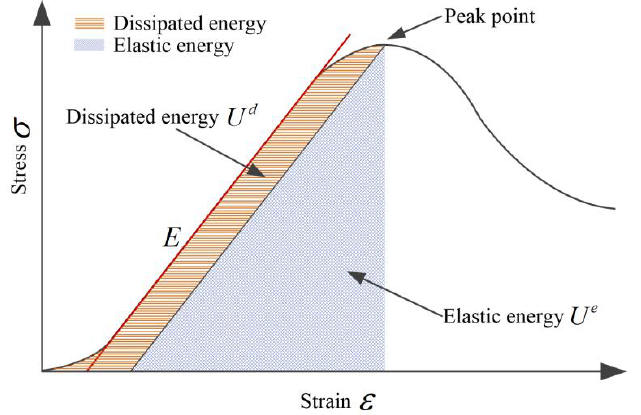
Figure 7. Different energy components obtained from the stress – strain curve (modified after [9]).